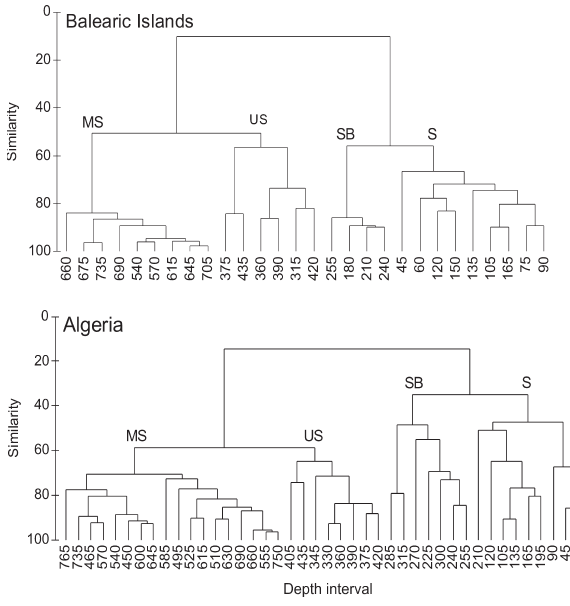
Y– : mean yields , per- i